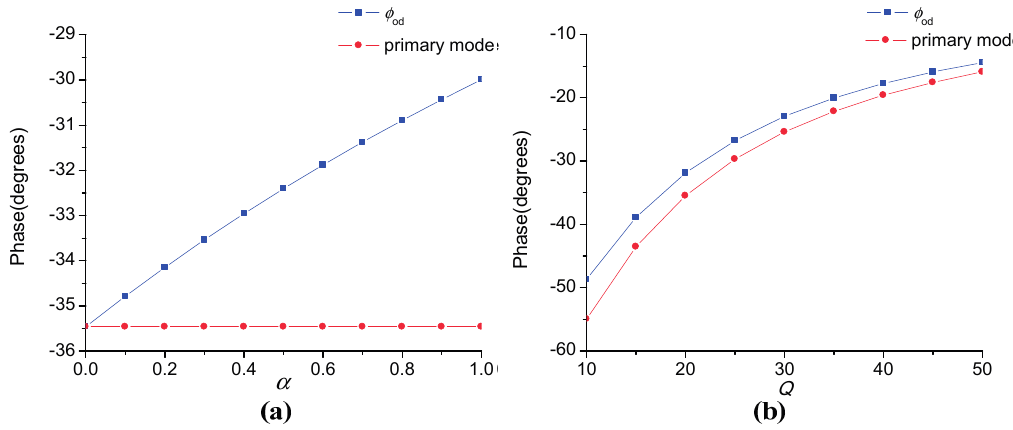
Figure 4. ( a ) The relationship between phase and (cid:2009) with the other parameters as = 2900 Hz , (cid:1858) (cid:1858) (cid:3041)(cid:3052)(cid:2869) between phase and Q with the other parameters as (cid:1858) (cid:1858) = 2800 Hz , (cid:2009) = 0.6 and (cid:1843) (cid:3031)